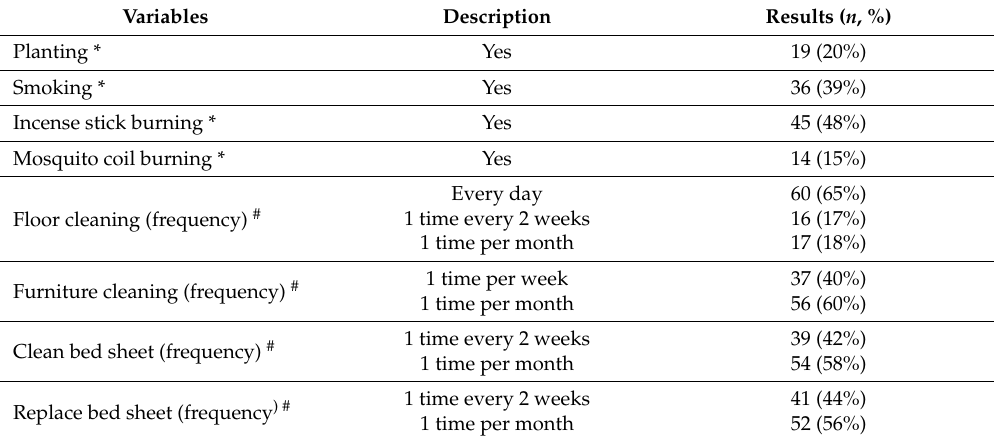
Table 2. Summary of human activities of 93 studied